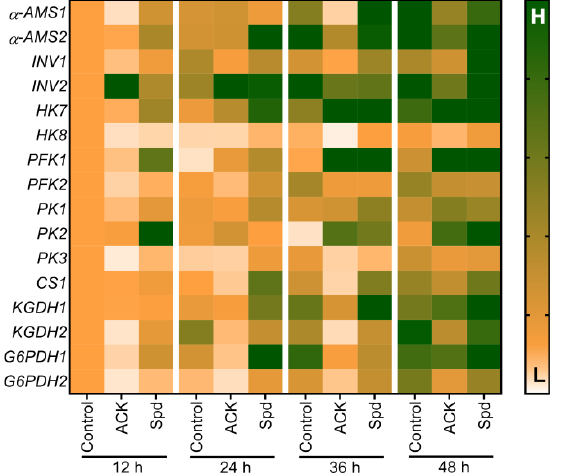
Figure 10. Exogenous Spd treatment increases the transcript levels of genes related to starch and sugar metabolism in aged sorghum seeds during germination. Control − healthy seeds; ACK − artificially aged seeds; A+Spd − aged seeds with Spd treatment. A total of four time points from 12 to 48 h after germination were performed for each treatment. α - AMS encodes α -amylase. INV encodes sucrose invertase. HK , PFK and PK encode hexokinase, phosphofructokinase, and pyruvate kinase, respectively. CS and KGDH encode Citrate synthase and α -ketoglutarate dehydrogenase, respectively. G6PDH encodes glucose-6-phosphate dehydrogenase. This heatmap was drawn by GraphPad prism software, and gene expression levels ranging from low (L) to high (H) are the smallest and largest in the entire database. A 0.05 µ M concentration of exogenous Spd was used.